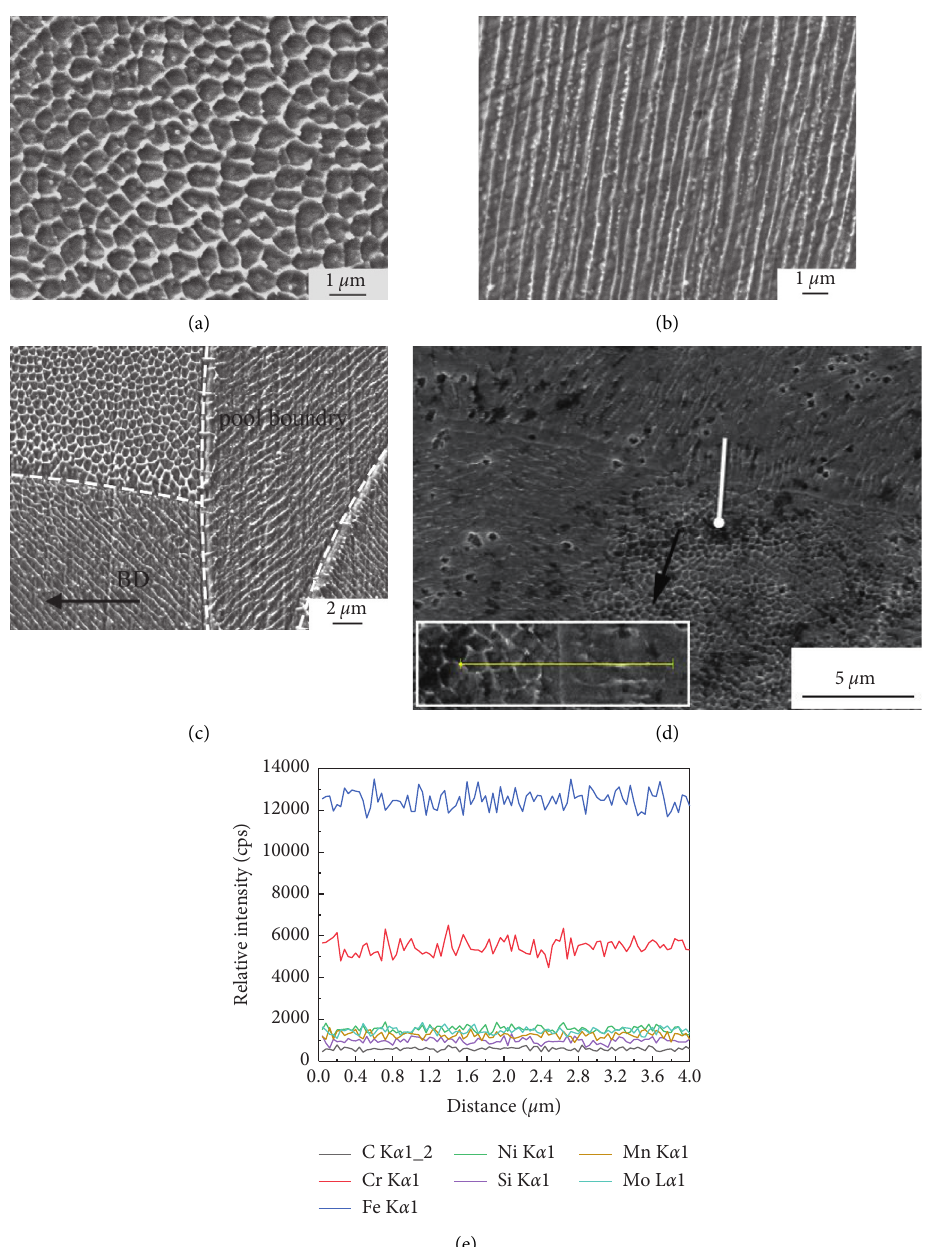
Figure 6: Microstructure and EDS analysis of the annealed SLM 316L stainless steel. (a) Transverse section of a cellular structure, (b) longitudinal section of a cellular structure, (c) growth direction of cellular crystal between adjacent molten pool boundaries, (d) scope of the EDS line scan, and (e) elemental analysis of the EDS line